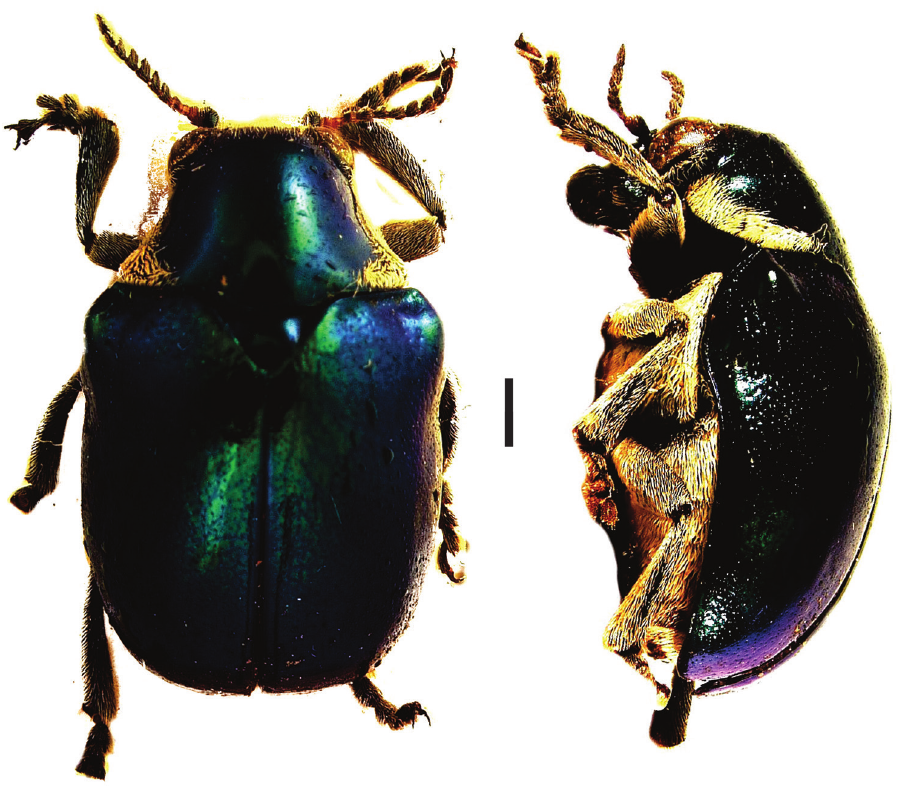
Figure 20. Themesia auricapilla grandis Baly (1) , left: habitus (dorsal view), right: habitus (lateral view).